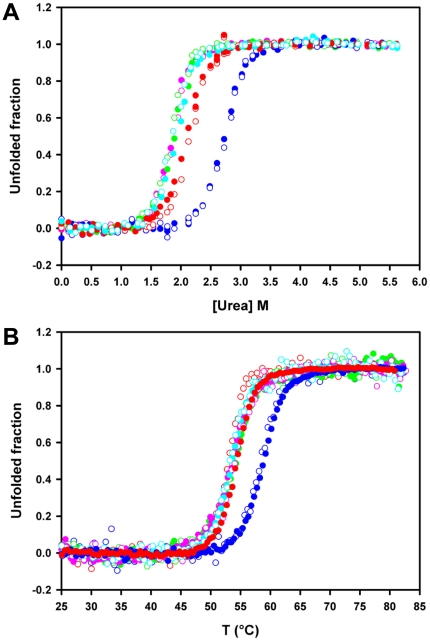
PolyQ insertions destabilize BlaP and the extent of destabilization is largely independent of the polyQ length.(A) Normalized urea-induced unfolding transitions at pH 7.5 and 25°C and (B) normalized heat-induced unfolding transitions at pH 7.5, monitored by the changes in fluorescence intensity at 323 nm (filled circles) and in ellipticty at 222 nm (open circles), using a protein concentration of 4.6 µM. BlaP (blue), BlaP(Gln)23 (red), BlaP(Gln)30 (green), BlaP(Gln)55 (pink) and BlaP(Gln)79 (cyan). Non-normalized data were analysed on the basis of a two-state model and the values of the thermodynamic parameters obtained are reported in Table 3.